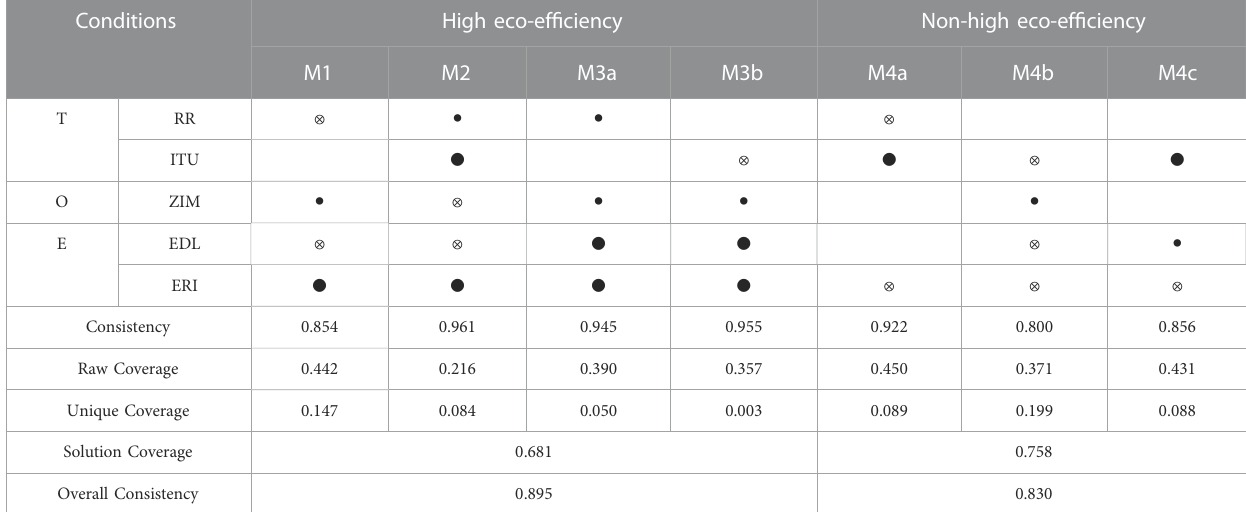
TABLE 6 Results of Con fi gurational Analysis with new Calibration Anchor Points Thresholds.